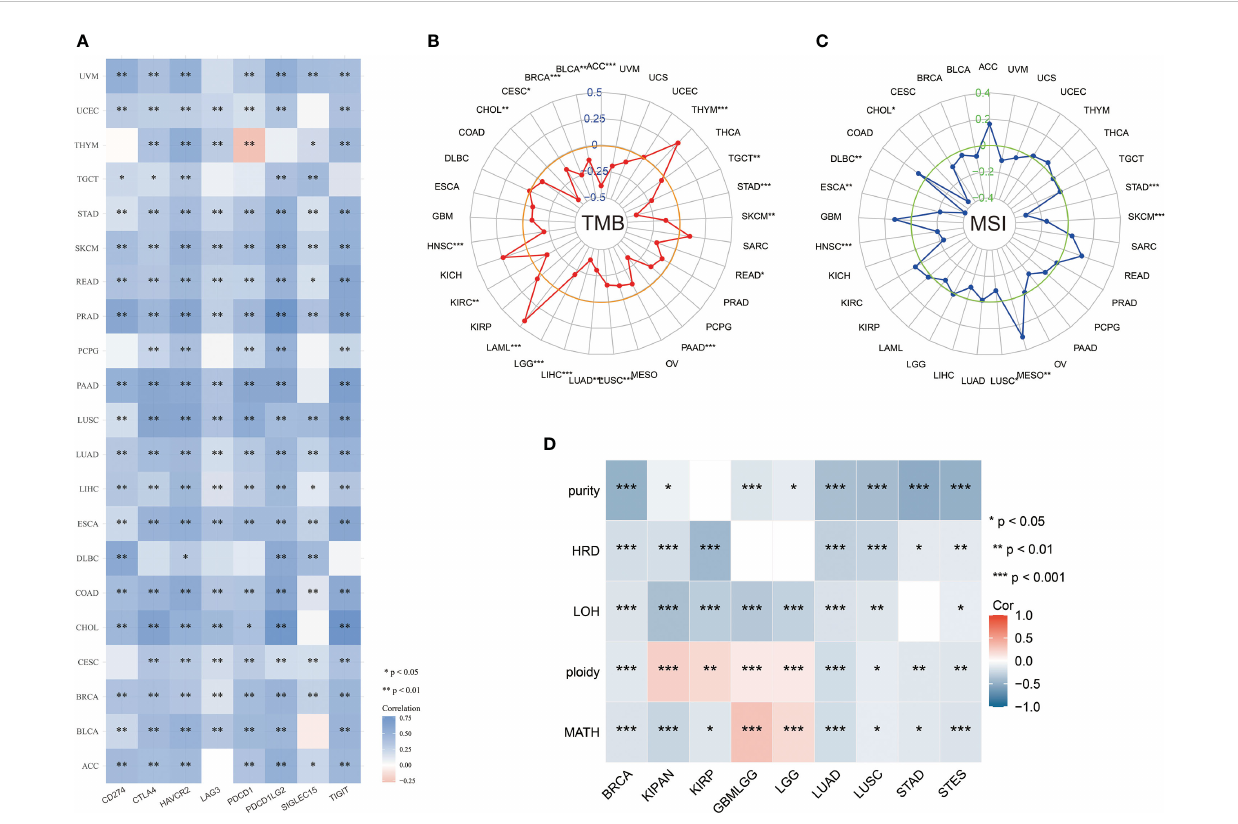
FIGURE 7 Relationship between ABI3BP expression and immune checkpoints and tumor heterogeneity. (A) Relationship between ABI3BP expression and immune checkpoints. Radar plot of ABI3BP expression in relation to TMB (B) and MSI (C) . (D) Relationship between ABI3BP expression and genomic heterogeneity. *, p < 0.05; **, p < 0.01; ***, p <